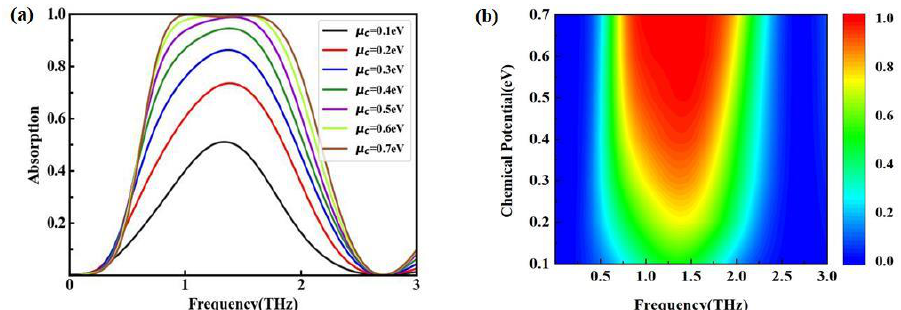
. ( a ) Absorption spectra; ( b ) absorption contour 𝑐